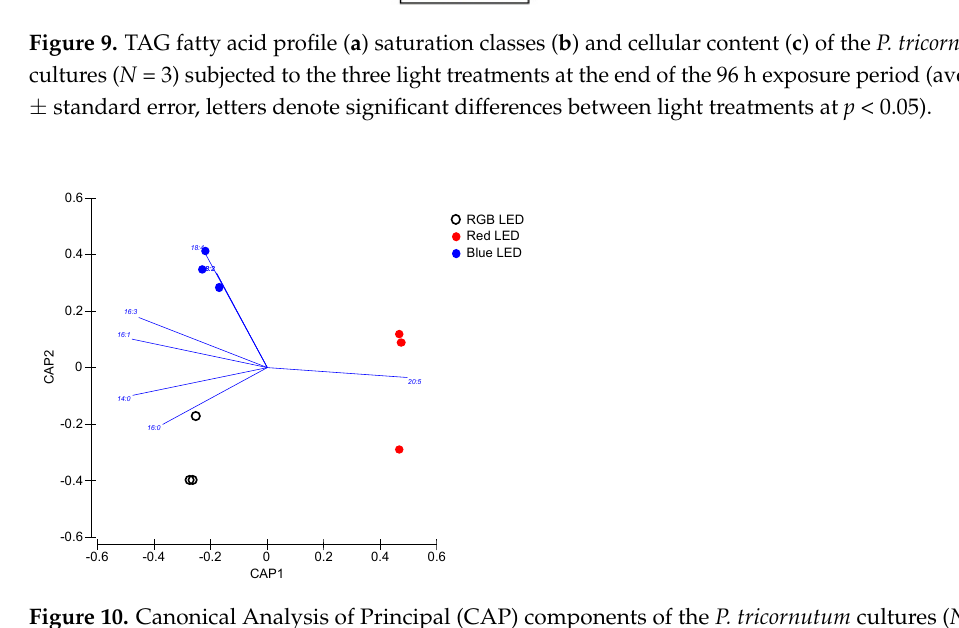
Figure 9. TAG fatty acid profile ( a ) saturation classes ( b ) and cellular content ( c ) of the P. tricornu- tum cultures ( N = 3) subjected to the three light treatments at the end of the 96 h exposure period (average ± standard error, letters denote significant differences between light treatments at p < 0.05).